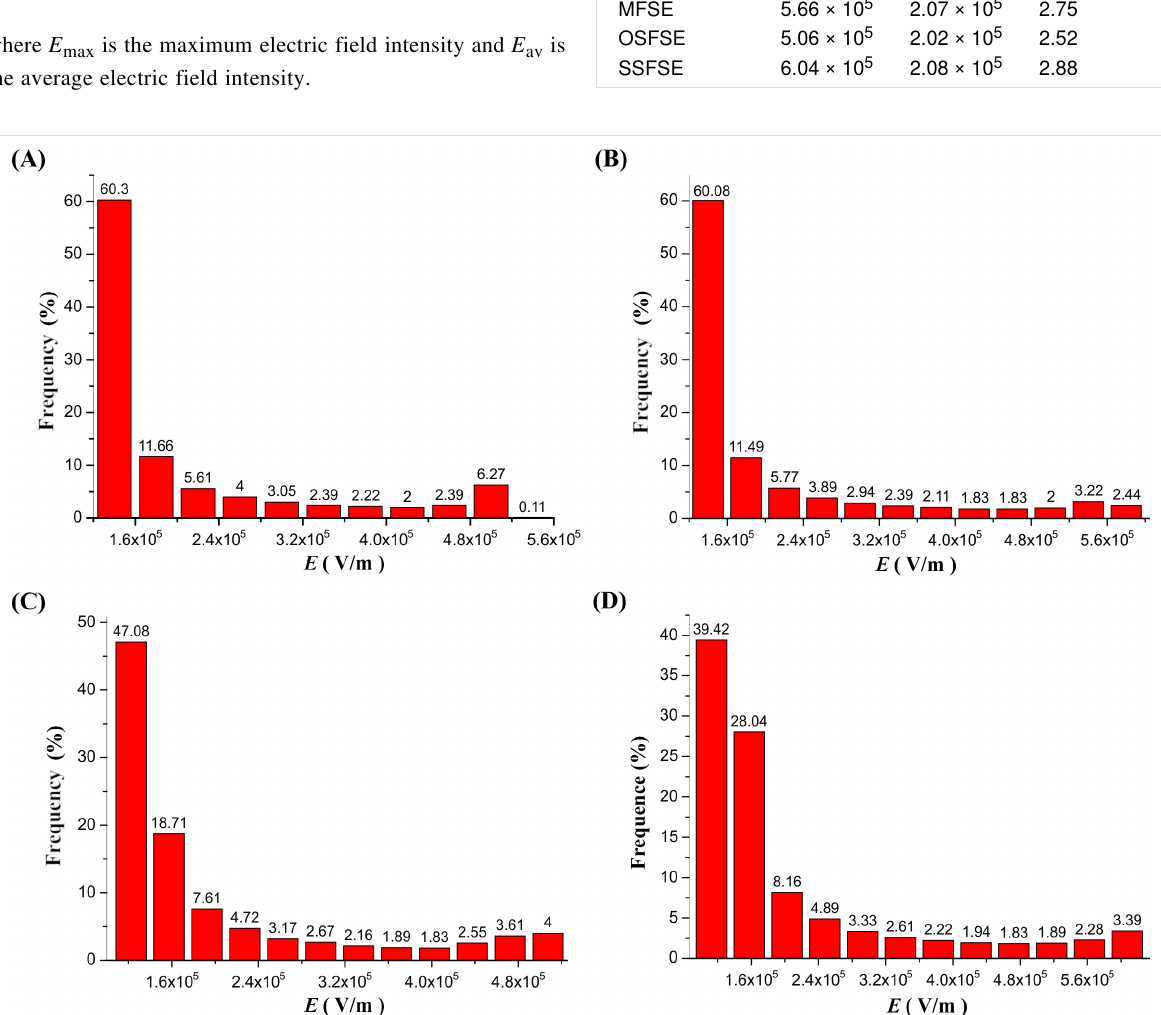
Table 2: Calculated values of E max , E av and ƒ along the center axis (0–180 mm) of the four self-made FSE